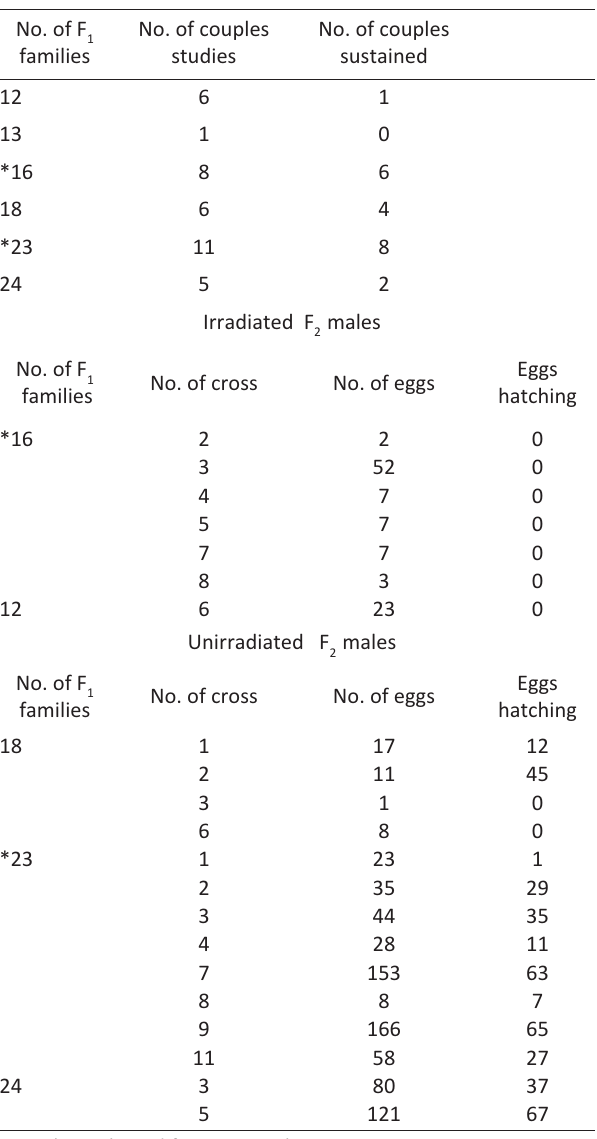
2 Table 4 - DNA samples for AFLP analysis